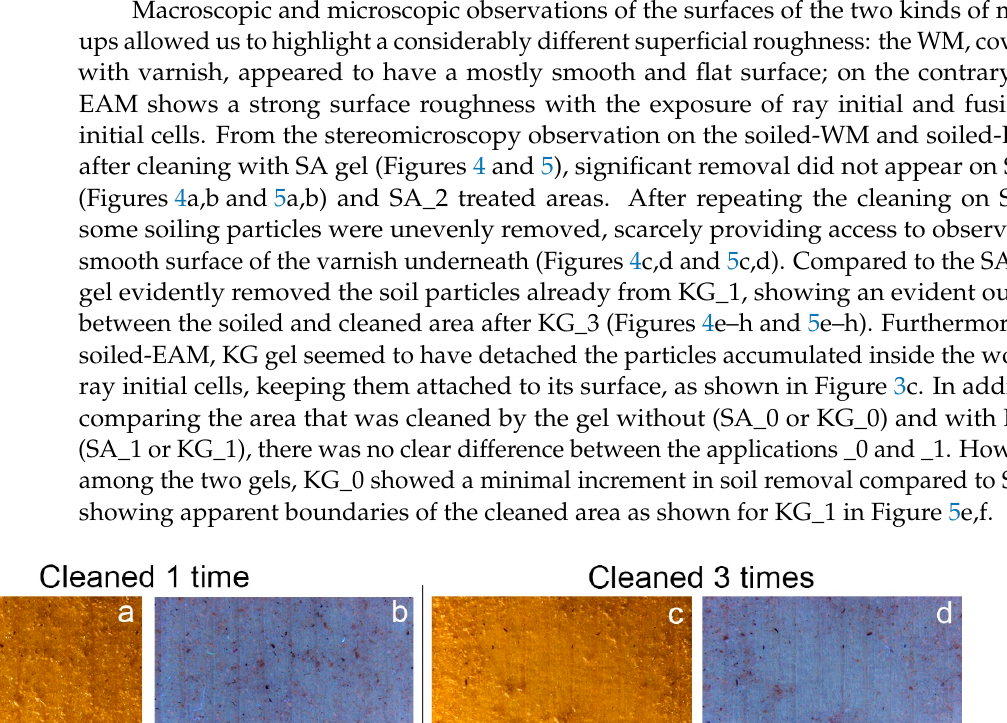
Figure 5. Stereomicroscopy images in visible and UV light of soiled-EAM cleaned at different ap- plication times with SA and KG gels: ( a , b ) SA_1, ( c , d ) SA_3, ( e , f ) KG_1, and ( g , h ) KG_3. After dispersing the sweat on the mock-ups, the sweat marks were only observed on the surface of the WM, while on the EAM, it was hardly recognized by stereomicroscope. This difference could be due to the hydrophobic varnish layer in the WM, which allowed more superficial crystallization of the dried sweat particles than the rough surface of EAM. After cleaning the sweat-WM, the removal efficacy was revealed only by UV light. Both SA and KG gels, with no difference by repeating the cleaning, were shown to par- tially remove the crystallization of sweat from the surface. 3.3. Colorimetric Measurements The complete data set with the color coordinates L * , a * , and b * acquired on both WM and EAM, before and after cleaning, is summarized in Table 2. The overall chromatic var- iation ( △ E * ) is reported in Table 3.